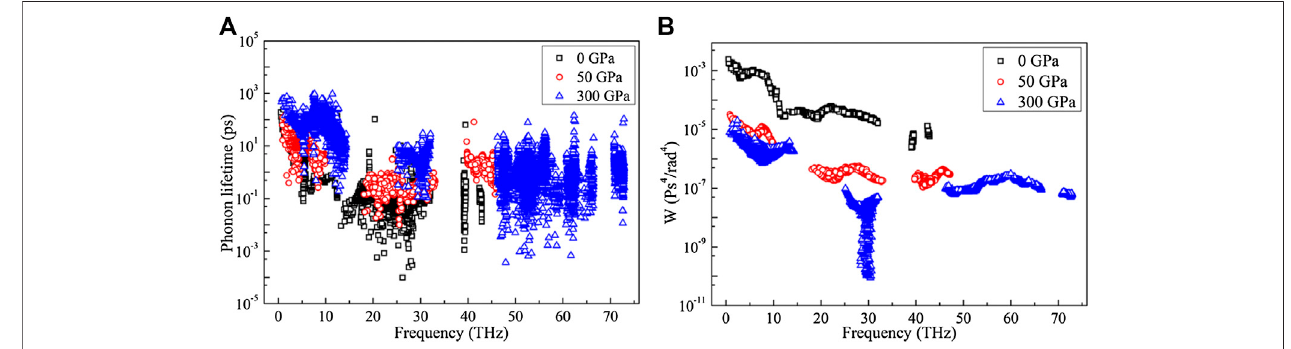
FIGURE 6 | The phonon lifetime (A) and phase space (B) of YH 3 under different pressures at 300 K.